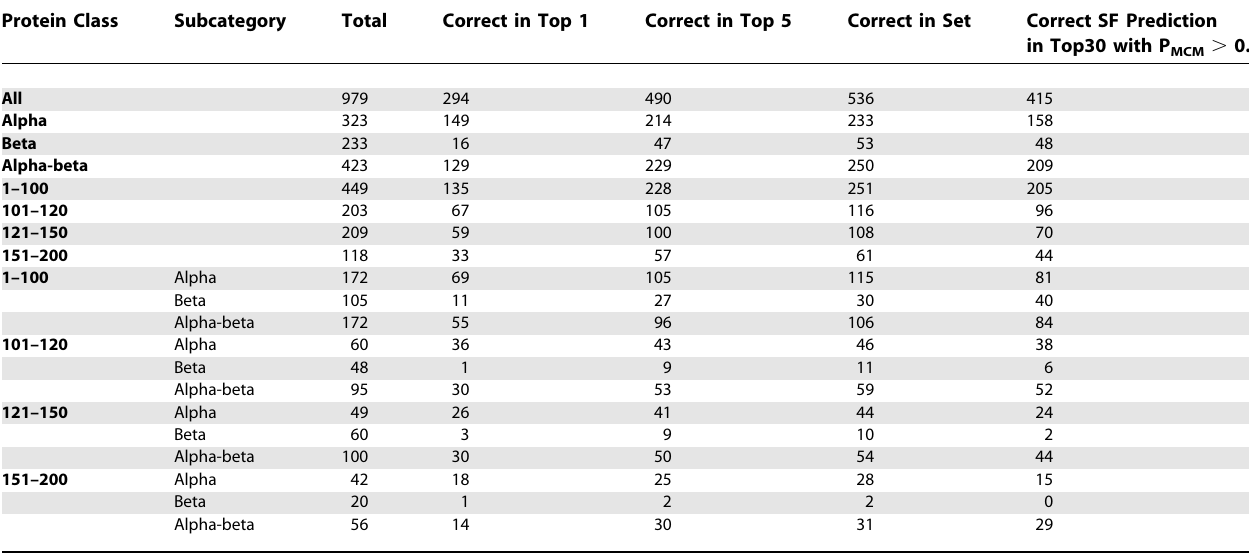
Table 5. Summary of Benchmark Results Protein Class Subcategory Total Correct in Top 1 Correct in Top 5 Correct in Set Correct SF Prediction